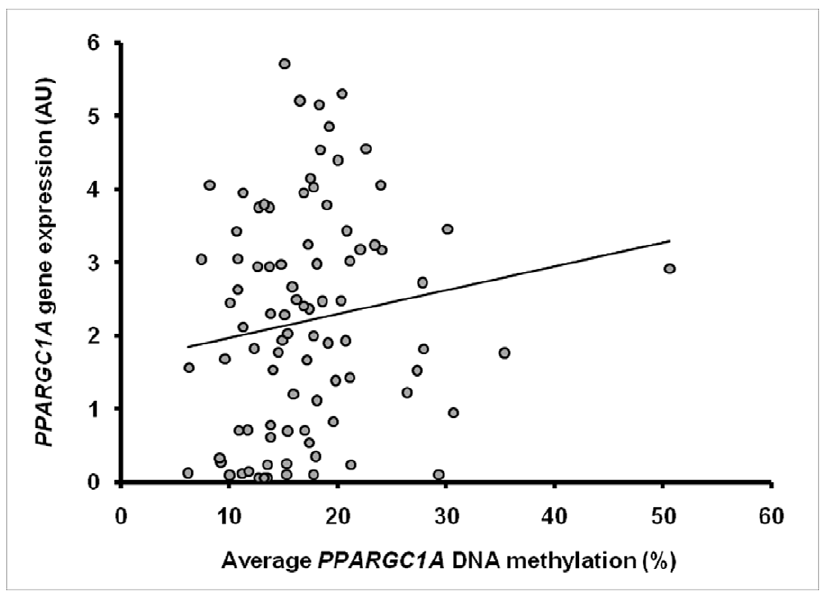
Figure 5. Correlation between average skeletal muscle DNA methylation and gene expression of PPARGC1A . Methylation is show in percentage and gene expression in arbitrary units (AU). b =0.013 ( 2 0.034;0.059), P= 0.59, adjusted for age, gender, BMI, glucose tolerance and family pedigree. Unadjusted (Spearman’s correlation): r 0.22, P =0.04.methylation at CpG site 2 260 in the PPARGC1A promoter was 0% in 98 individuals and 4–10% in 11 individuals (4 with T2D and 7 with NGT). The DNA methylation at CpG site 2 260 was not different among T2D (1.1 6 1.7) compared to NGT subjects (0.74 6 2.3), and there were no significant associations between DNA methylation and whole body insulin sensitivity, gene expression or any other clinical parameter (data not shown).